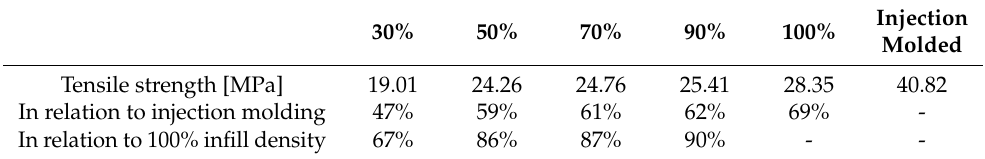
Table 3. Tensile stress results depending on the infill density of printed